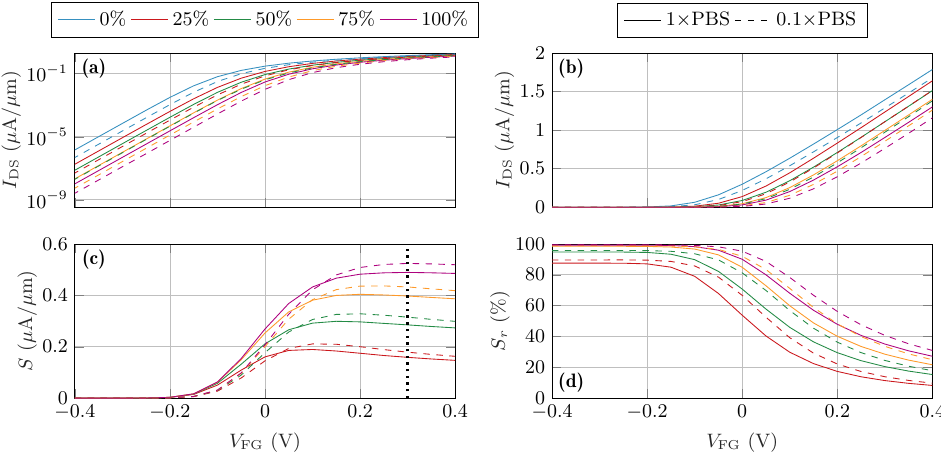
Figure 3. ( a ) Current density I DS − V FG shown in logarithmic scale. ( b ) Current density I DS − V FG shown in linear scale. ( c ) Absolute current sensitivity S − V FG . ( d ) Relative current sensitivity S r − V FG . All results are calculated for different values of P with a uniform spatial distribution of receptors. Solid and dashed lines correspond to the 1 × PBS electrolyte and 0.1 × PBS electrolyte scenarios, respectively. The dotted line in (c) indicates the value V FG = 0.3 V for which S ( P = 100% ) is